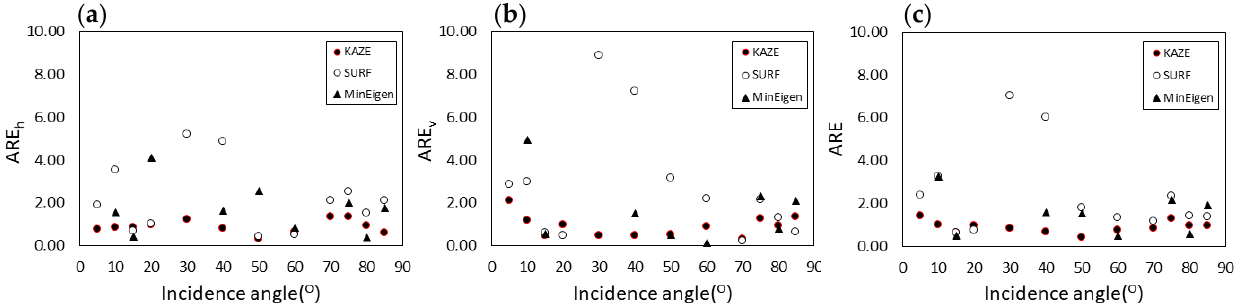
Figure 8. Distribution of ARE h , ARE v , and ARE with different feature matching methods at facing displacement. ( a ) ARE h ; ( b ) ARE v ; ( c ) ARE. Table 1. Average and standard deviation of ARE h , ARE v , and ARE with different feature matching methods.